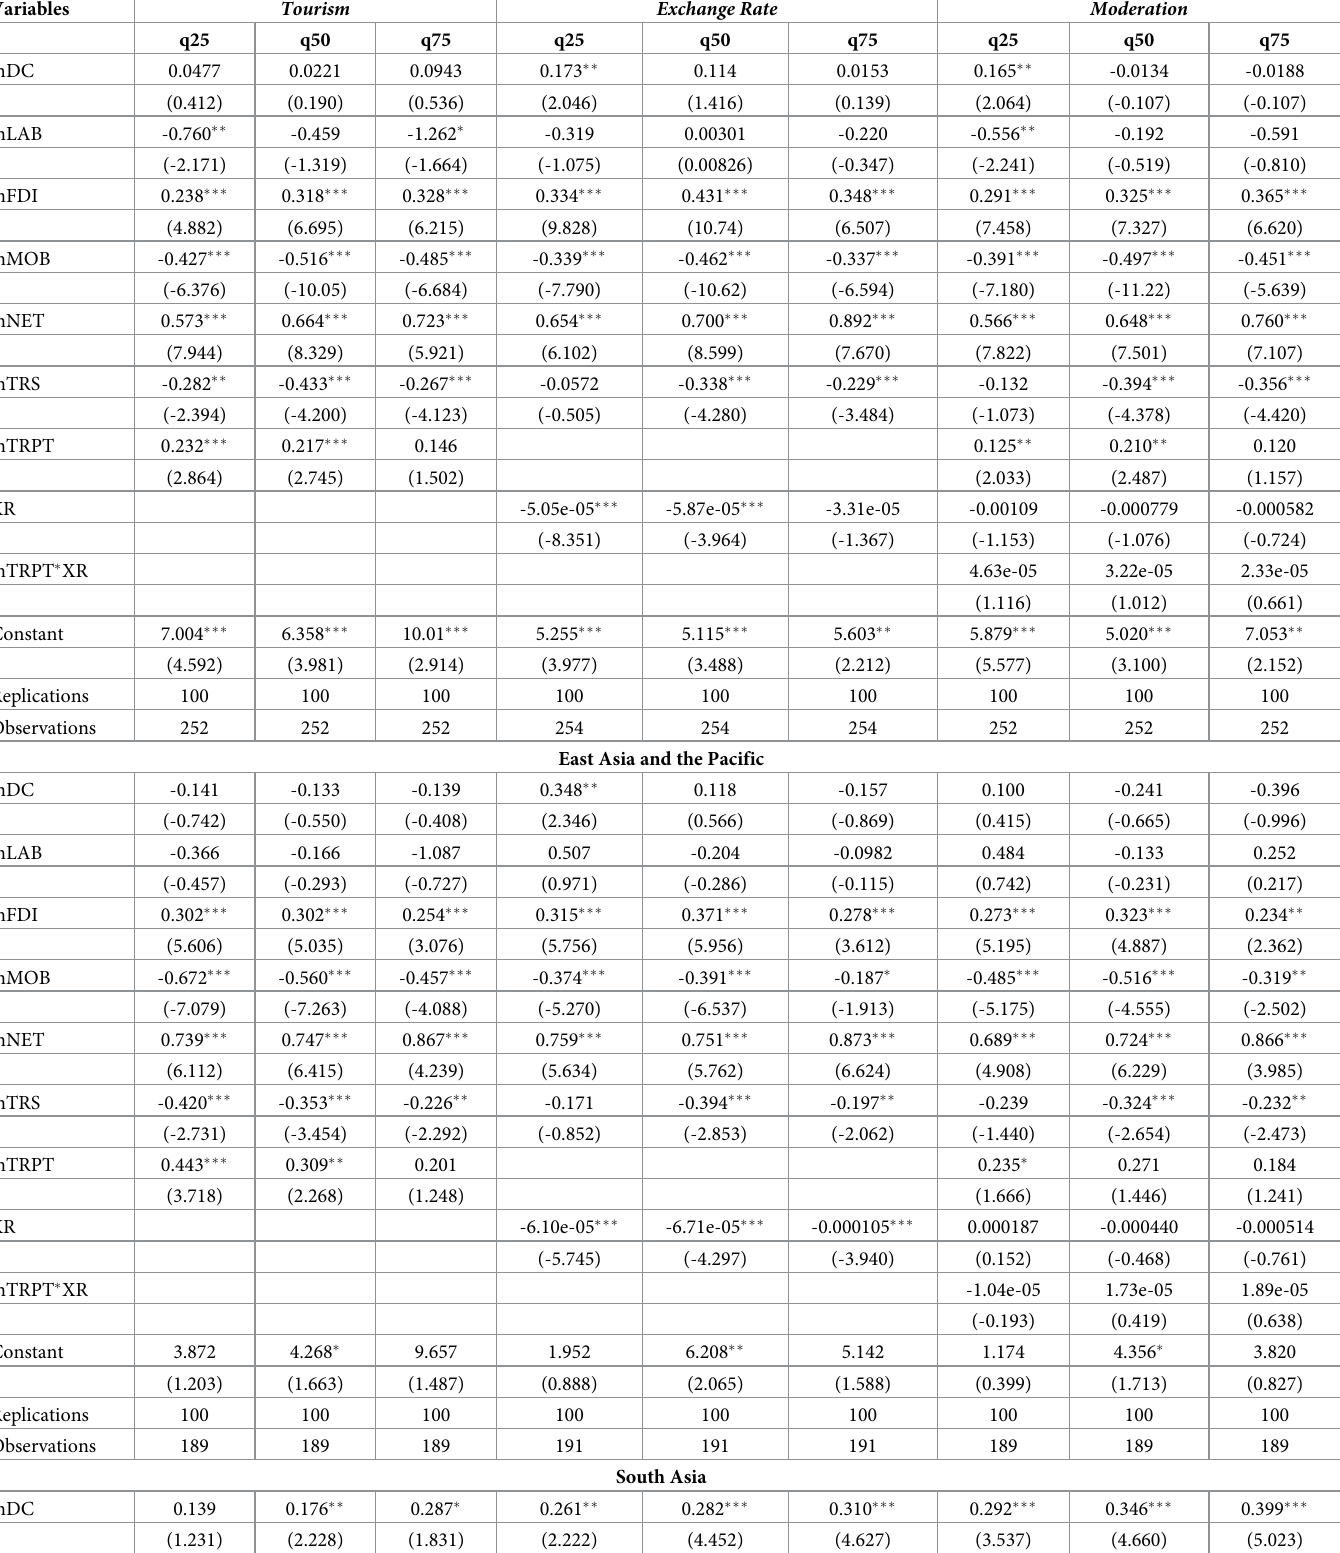
Table 4. Quantile regression results for the full and sub-samples (Dep Var: lnPC).